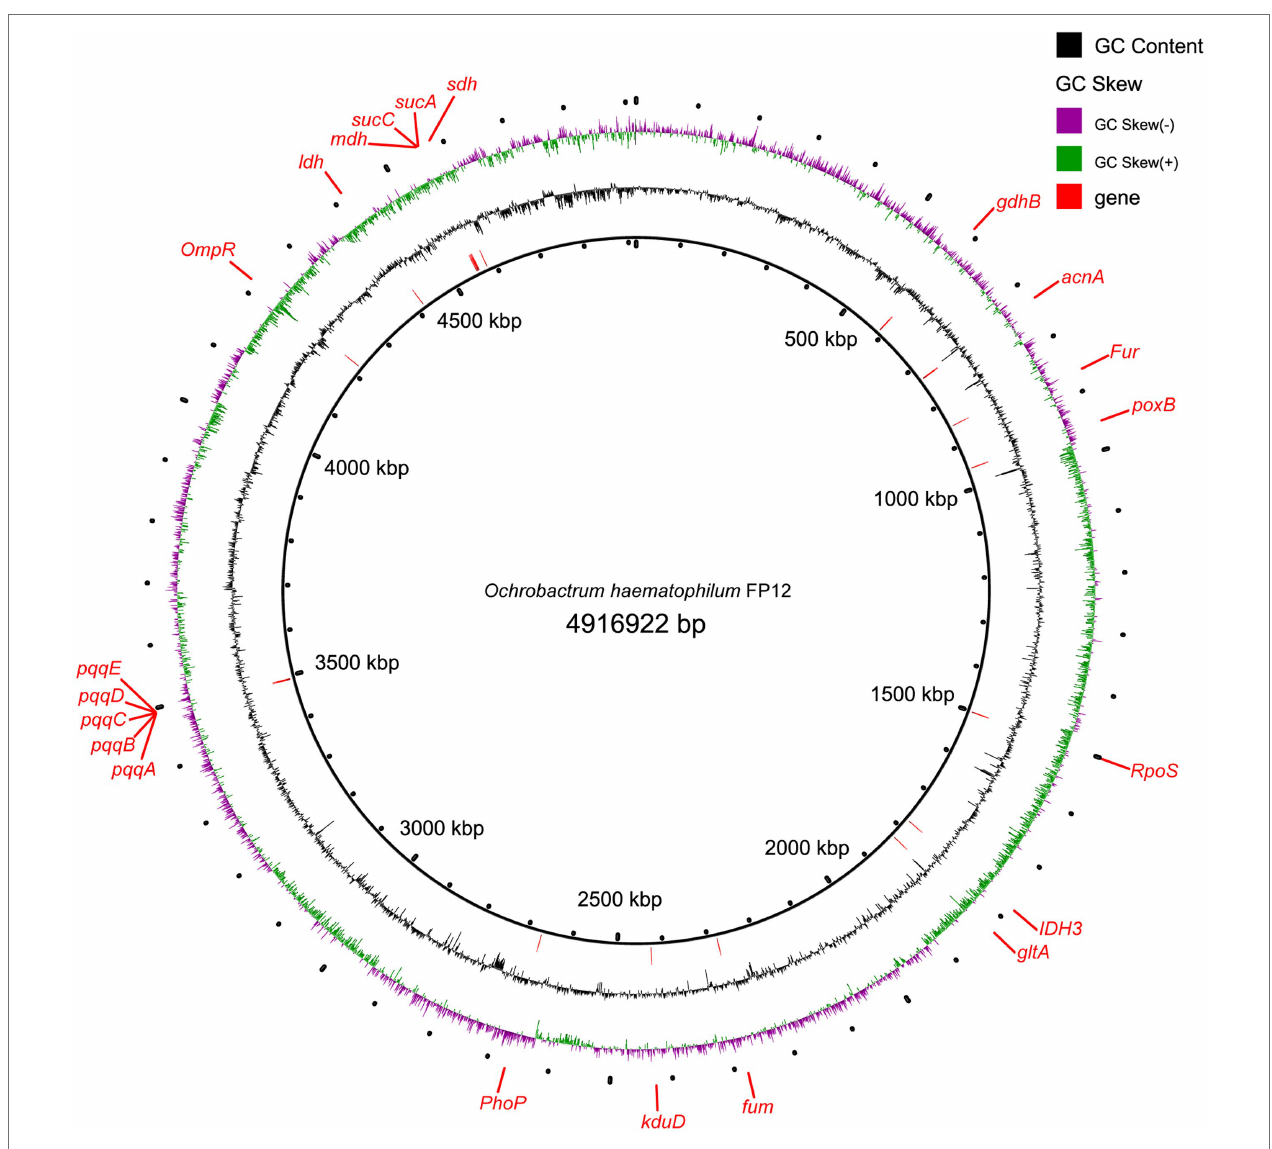
FIGURE 3 | The genome of Ochrobactrum haematophilum FP12 and genes related to